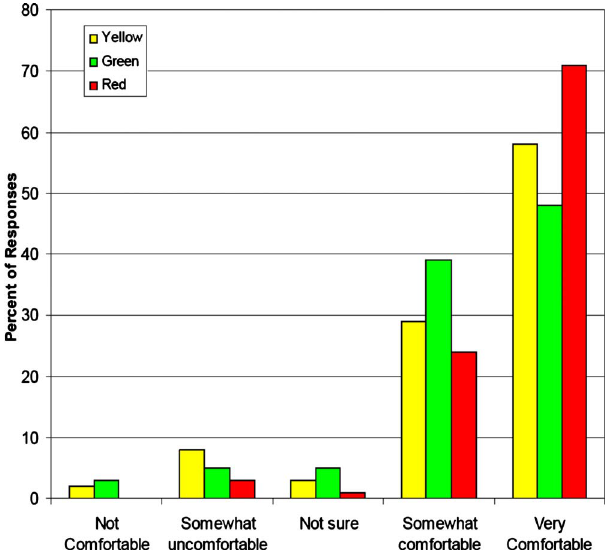
FIG. 6. (cid:1) Color (cid:2) Example question—distribution of student re- sponses to Comfort level discussing physics with student peers (cid:1) Q14